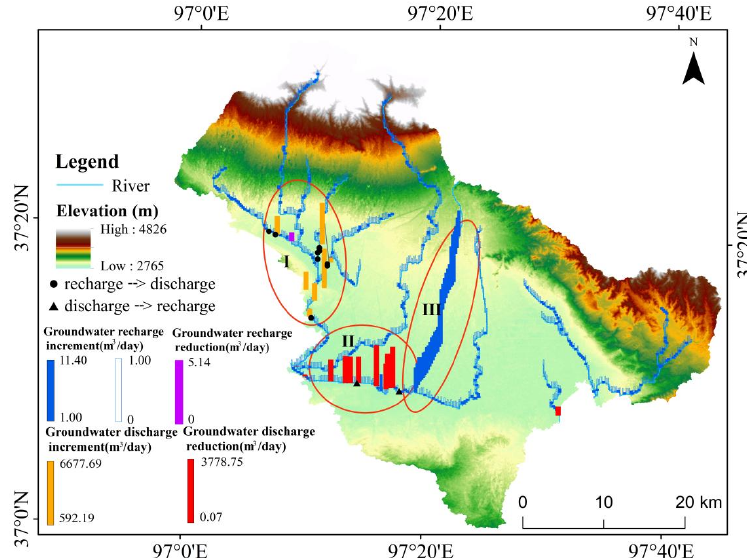
Figure 16. Revegetation impacts on groundwater recharge and discharge.